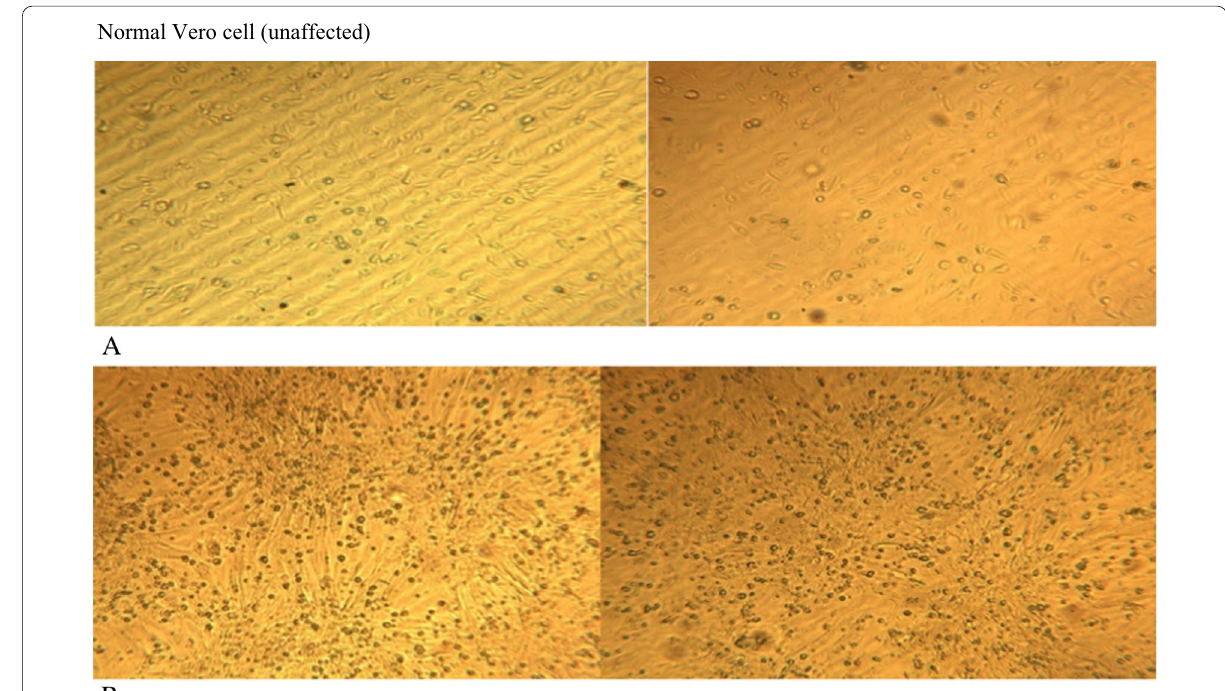
Fig. 1 African green monkey Vero cell cultures before (top left) or non-inoculated normal monolayers (top right) ( A ), and CPE observed four days post-infection ( B ). The figure demonstrates a monolayer of African green monkey Vero cells cultures after infection with camel contagious ecthyma virus (CCEV). The inoculated virus produced a CPE characterized by cell rounding and enlargement, pyknosis, granularity of the cytoplasm and cell detachment